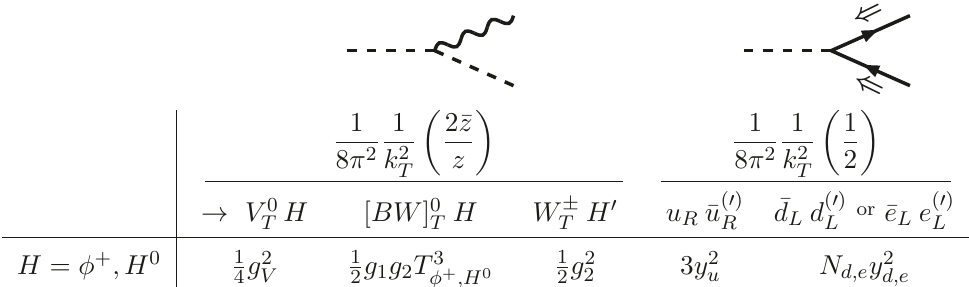
Transverse vector boson splitting functions d allowed by electric charge flow. N f is a color multiplicity factor ( N f = 1 for leptons, N f = 3 for quarks). Other conventions as in table 1.